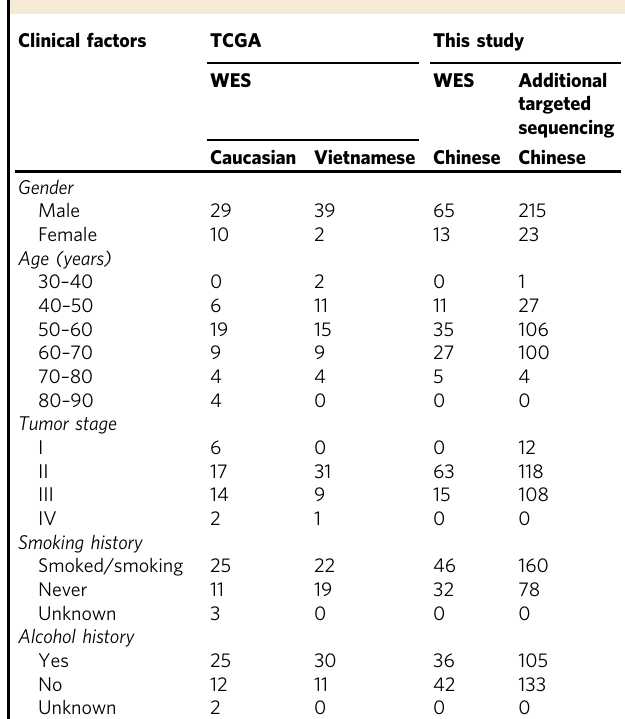
Table 1 Characteristics of patient cohorts surveyed in